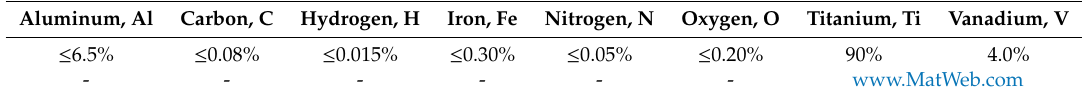
Table 7. Component elements’ properties.